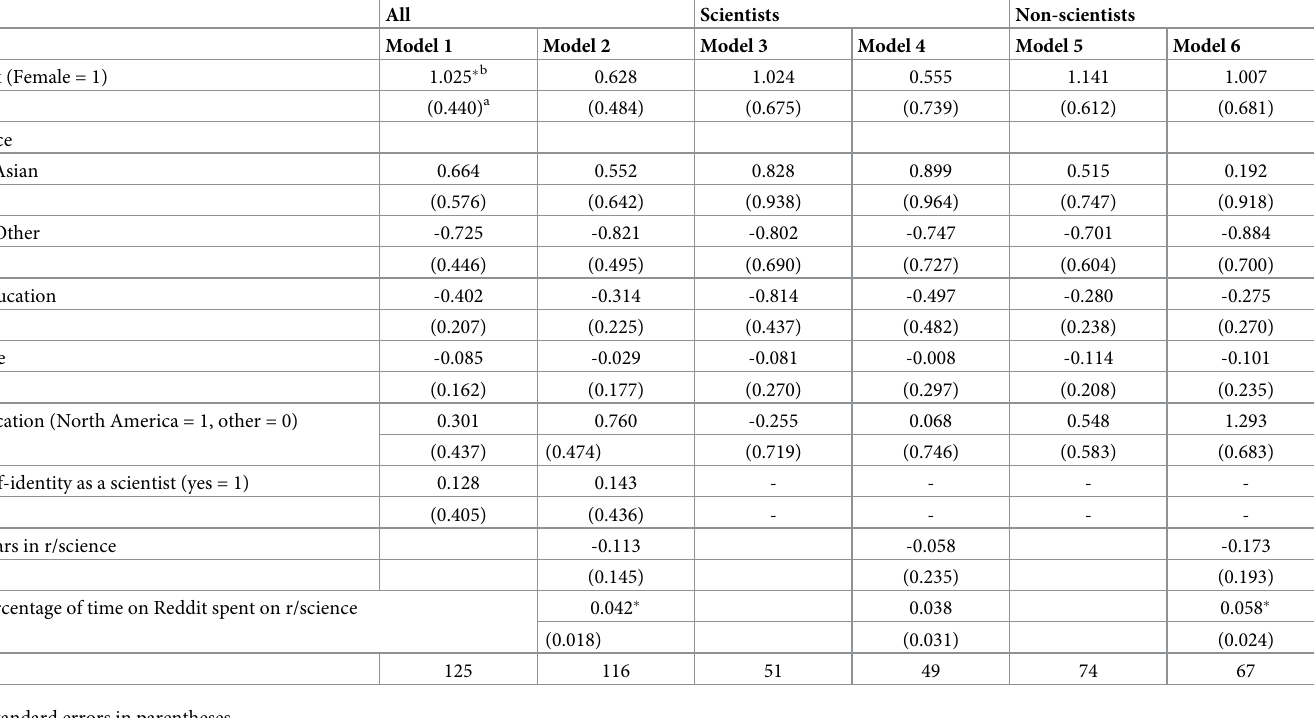
Table 5. Results of ordinal logistic regression of users’ demographics on the perceived effect of r/science helping individuals make informed decisions based on science.